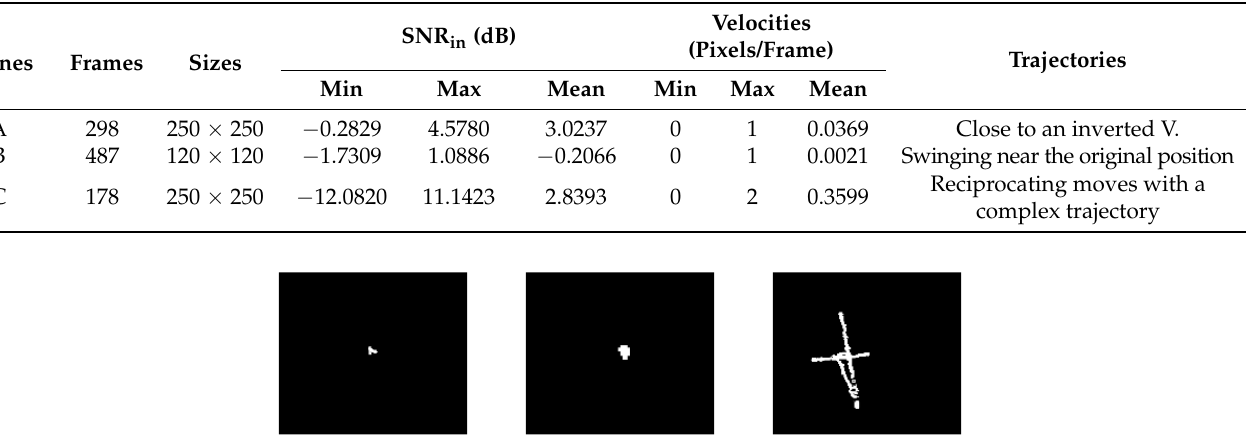
Table 3. The energy, velocity, and trajectory characteristics of the target.